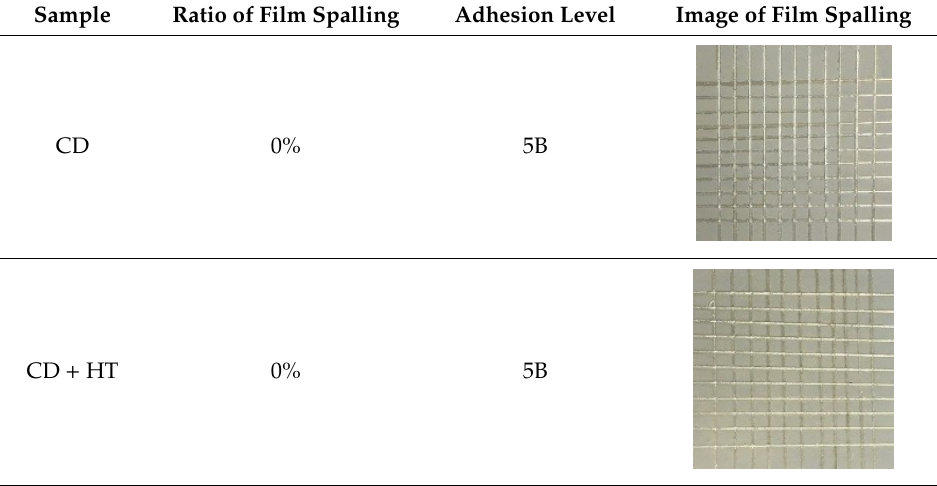
Table 5. Adhesion test results of typical samples.